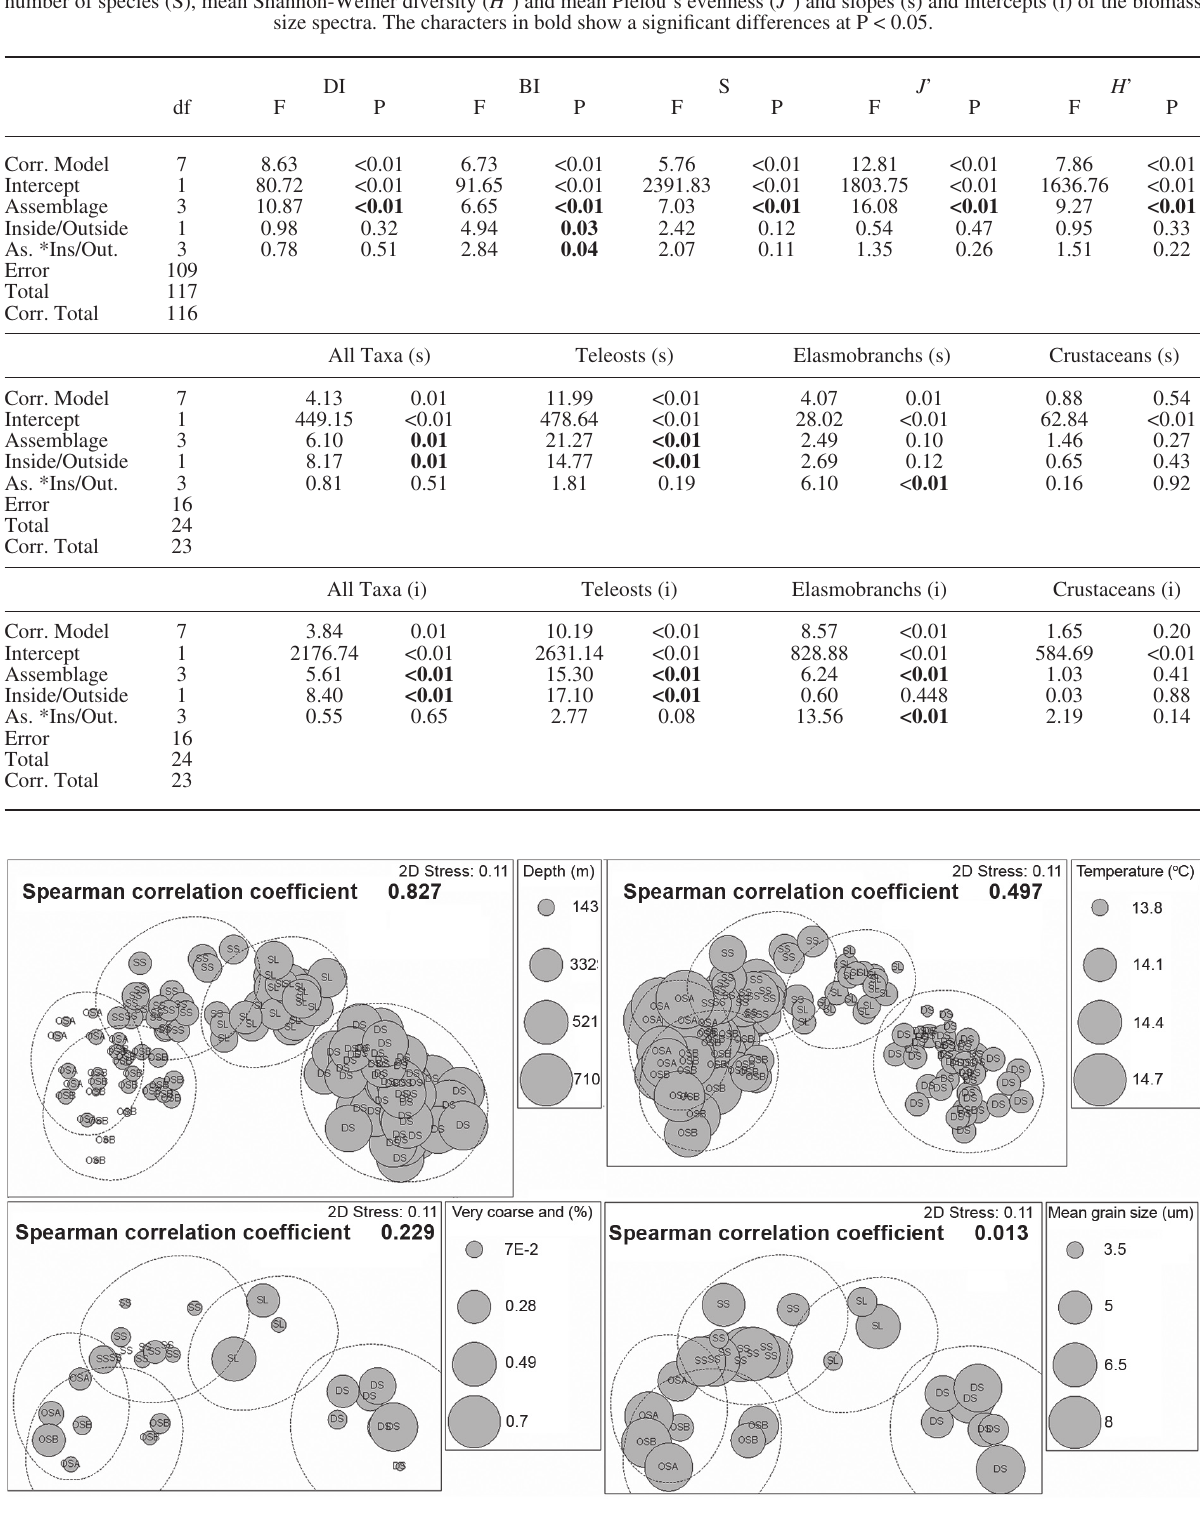
Fig 4. – The nMDS plot from Figure 2 with scaled values of (A) depth, (B) temperature, (C) % very coarse sand, and (D) % mean sediment grain size (µm). The Spearman correlation coefficient for each parameter is also